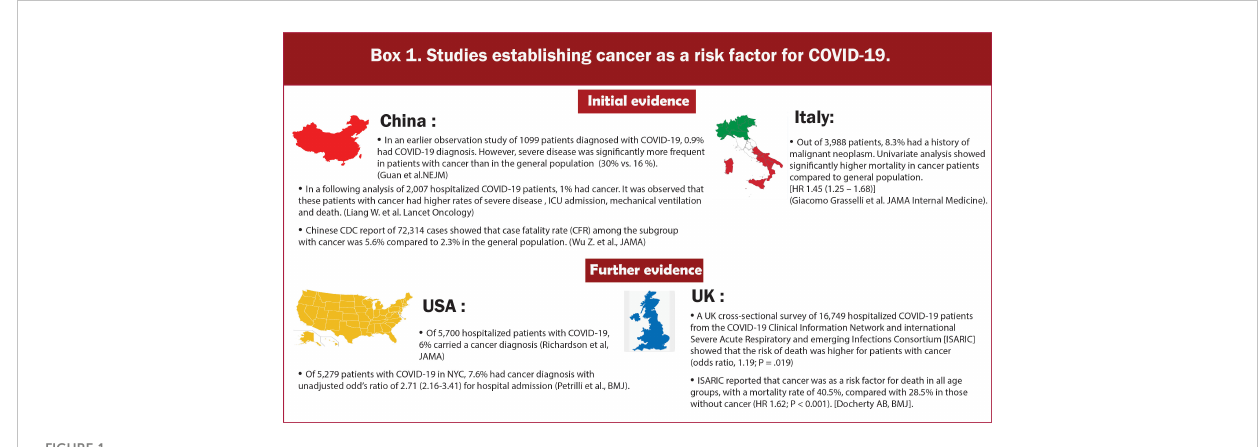
FIGURE 1 Box-1 Studies establishing cancer as a risk factor for COVID-19.